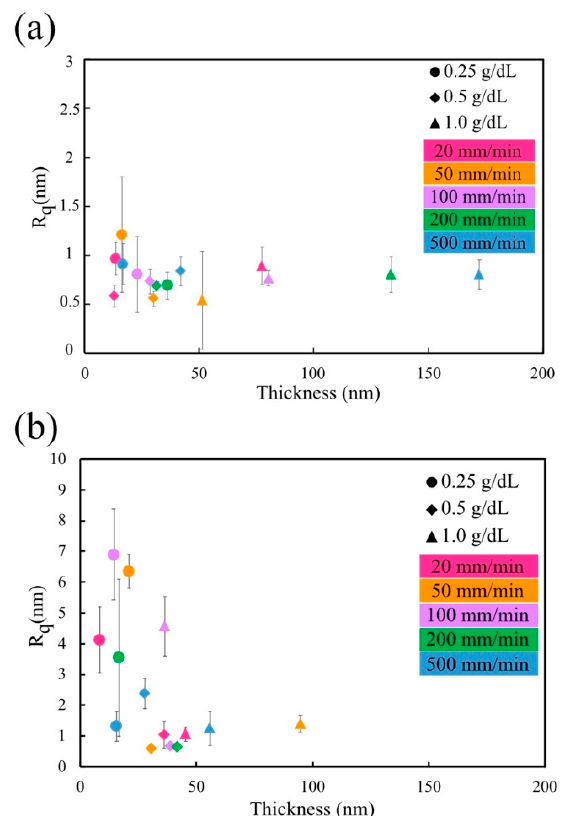
Figure 10. The roughness dependence of the solid film on its thickness: ( a ) high-molecular-weight PVB(B72) solution; ( b ) low-molecular-weight PVB(B98) solution.